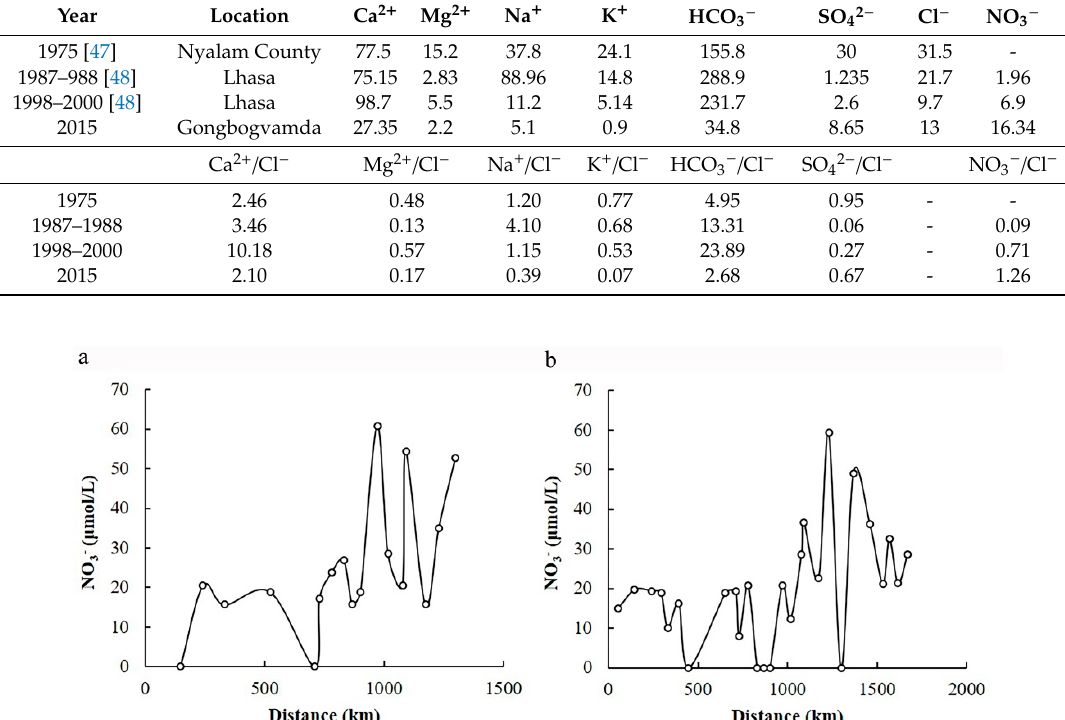
Table 4. Solute chemistry of rainwater in or near the Yarlung Tsangpo River Basin ( µ mol / L).